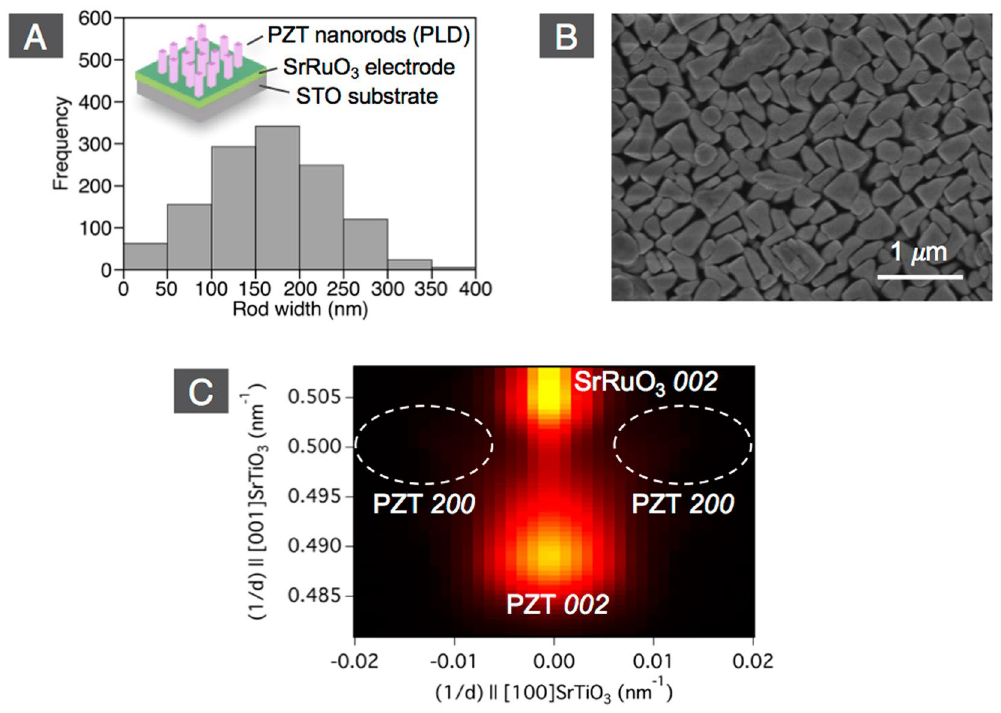
Figure 4. Self-assembled PZT nanorods grown on SrRuO 3 /STO(100) by PLD. ( A ) rod width distribution, ( B ) top-view SEM image, and ( C ) XRD reciprocal space map around PZT 002 and